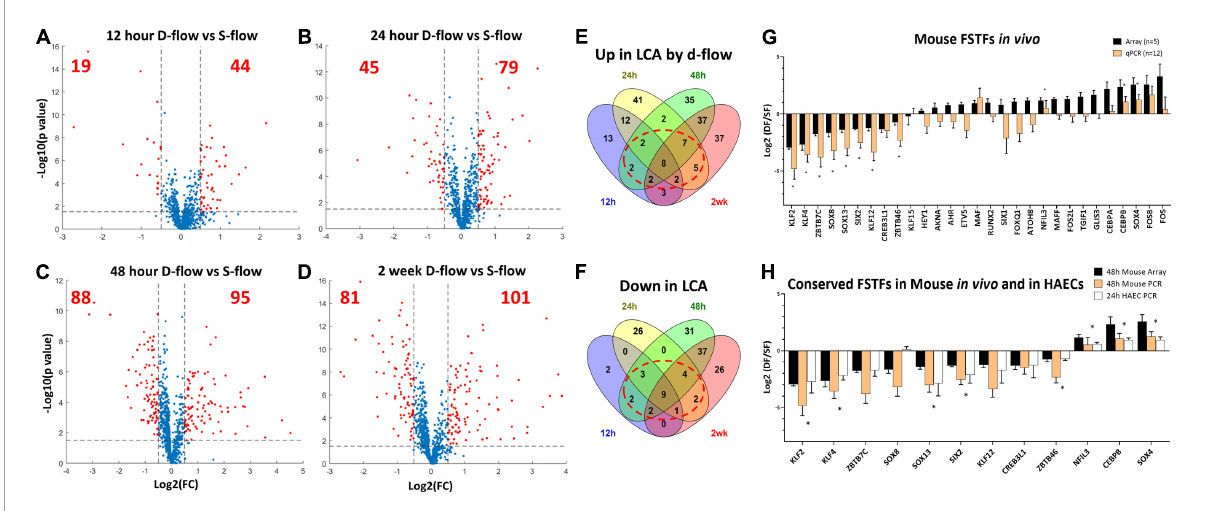
FIGURE1 Identification of flow-sensitive transcription factors (FSTFs) in mouse artery ECs in vivo and validation in vivo and in vitro . Volcano plots show differentially expressed TFs in endothelial-enriched RNAs in the LCAs (left carotid artery exposed to d-flow) and RCAs (right carotid artery exposed to s-flow) obtained at (A) 12 h, (B) 24 h, (C) 48 h, and (D) 2 weeks after the PCL in mice. Red dots indicate TFs changed ≥ 50% with a p -value ≤ 0.05. (E,F) Venn diagrams show TFs commonly upregulated or downregulated by d-flow at 3 or 4 different time points. (G) qPCR validation of 29 potential FSTFs at 48 h post-PCL. Mean fold change ± SEM, n = 12 for qPCR, (*) indicates p ≤ 0.05 for qPCR results calculated by student’s t -test. (H) The in vivo gene array and qPCR data at 48 h post-PCL results are compared to the in vitro qPCR results in HAECs